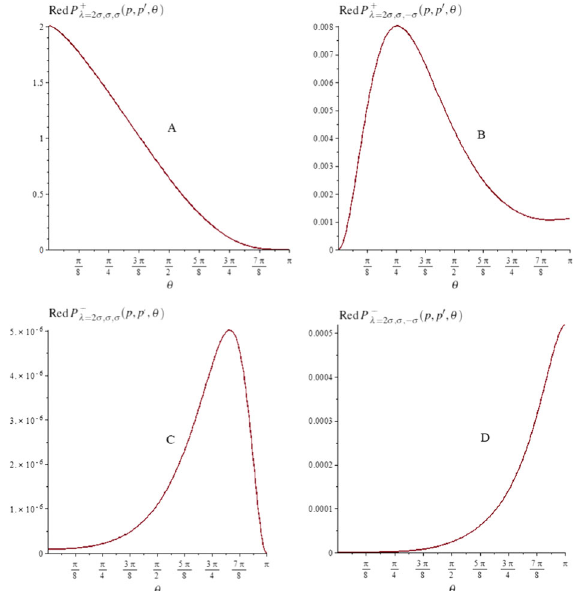
Fig. 4 Thereducedp.v.t.sversus θ forthepaircreation(+)intheupper panels and for the lepton creation ( − ) in the lower